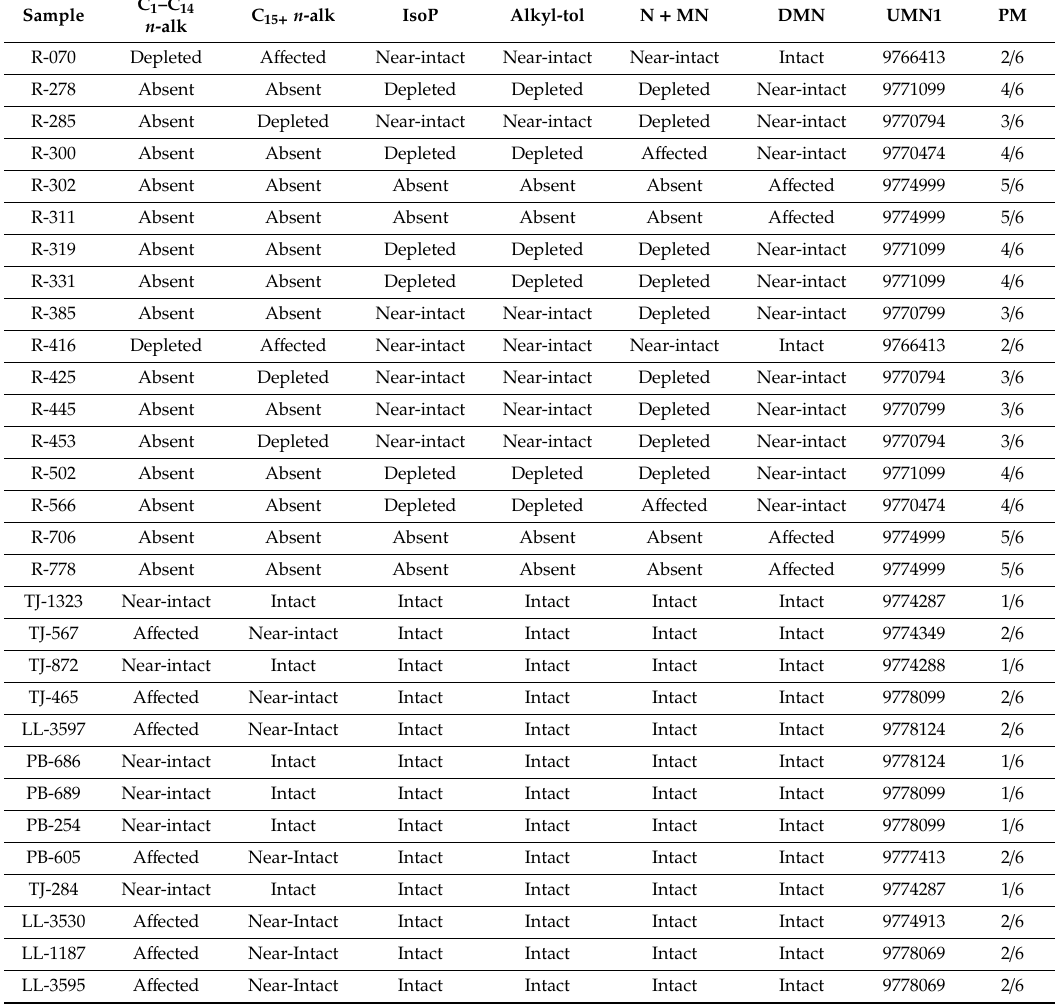
Table 2. PM and Manco biodegradation levels of the oils